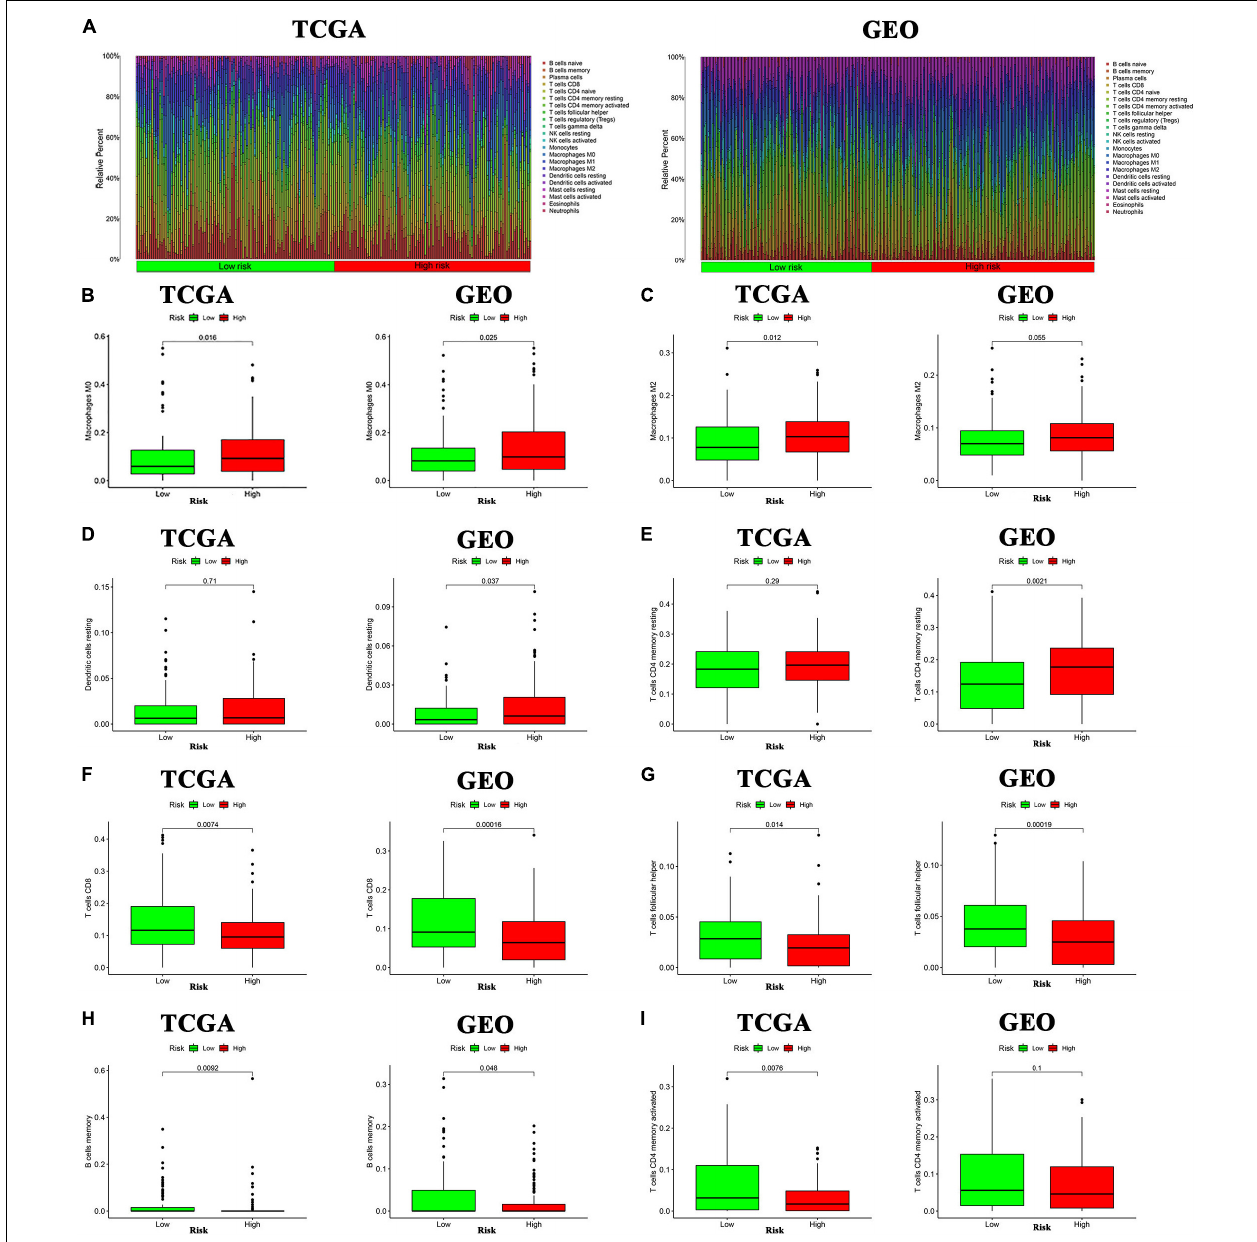
FIGURE 11 | Analysis of immune cells in the high- and low-inflammatory risk group for GC. (A) Relative proportion of immune infiltration in high- and low-inflammatory risk patients. (B–I) Box plot visualizing the differentially infiltrated immune cells in the two